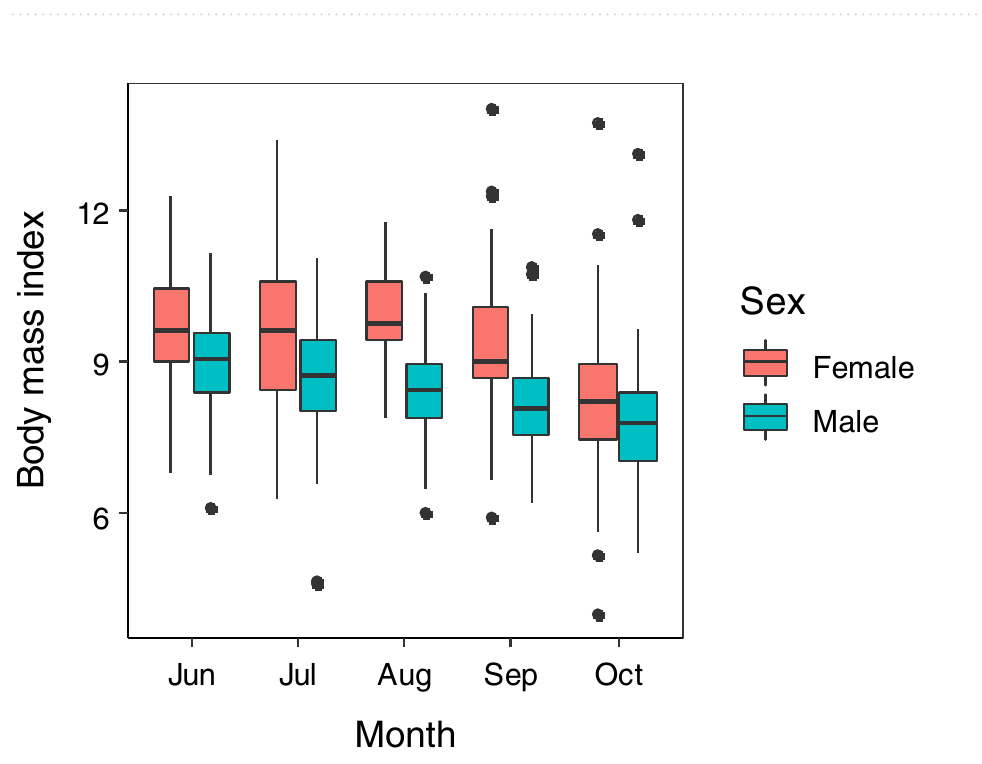
Figure 5. Boxplot of body mass index (BMI) of females and males of Laguncula pulchella (≥ 25 mm shell height) collected in Matsukawaura Lagoon between June and October. Data from 2015 to 2018 were pooled (the data each year are shown in ESM Fig. S1). Boxes show the 25% and 75% quartiles and median, vertical bars represent the maximum and minimum values, and solid circles represent